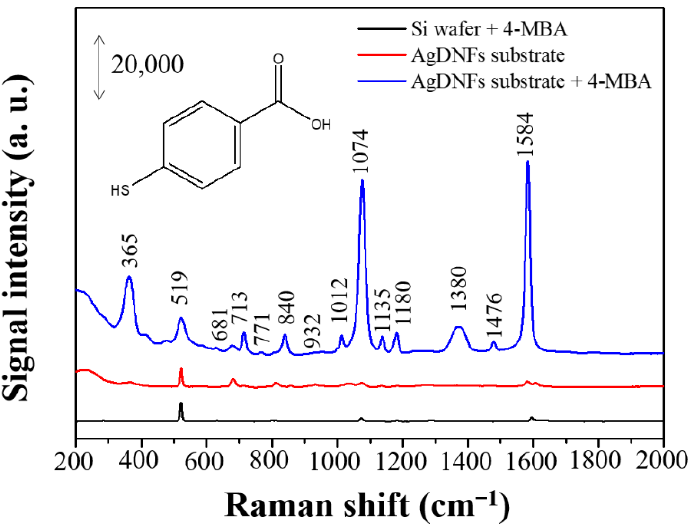
Figure 1. Normal Raman spectrum of 10 mM 4-MBA (black line) on silicon wafer and SERS spectra of 0 µ M (red line) and 100 µ M 4-MBA (blue line) on the dendritic forest-like Ag nanostructures. Table 1. Experimental Raman shift (cm − 1 ) of 4-MBA on the dendritic forest-like Ag nanostructures. Raman Shift (cm − 1 )